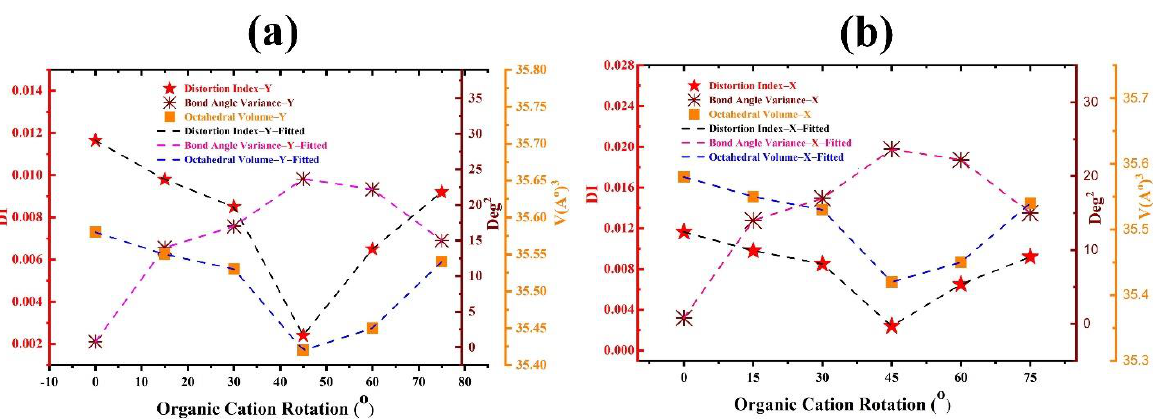
Figure 4. Two-dimensional depiction of electron density of FAPbBr 3 perovskite for rotational modes of: ( a ) 0 ◦ -X, ( b ) 15 ◦ -Y, ( c ) 30 ◦ -Y ( d ) 45 ◦ -Y, ( e ) 60 ◦ -Y, ( f ) 75 ◦ -Y, ( g ) 15 ◦ -X, ( h ) 30 ◦ -X, ( i ) 45 ◦ -X, ( j ) 60 ◦ -X and ( k ) 75 ◦ -X.